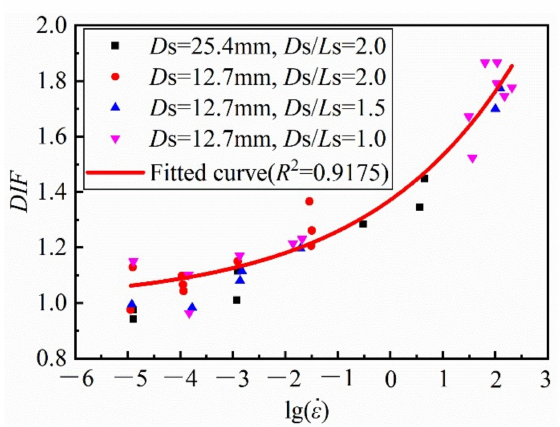
Figure 20. Relationship between DIF and strain rate of Indian limestone.